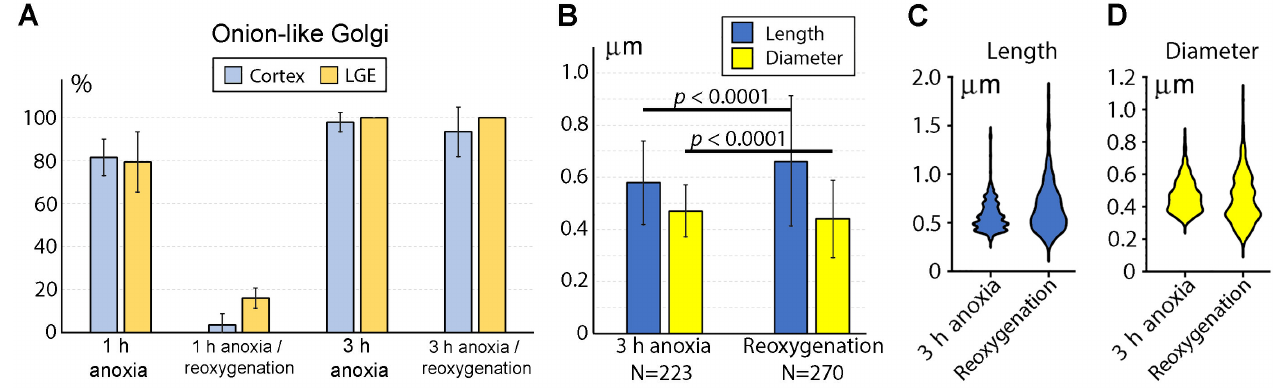
Figure 4. ( A ) Reoxygenation of the anoxia-exposed mouse embryo brains down-regulates percentage of the onion-like GA after 1 h, but not after 3 h anoxia. Percentages of swirled GA are expressed as mean ± SD for each spatiotemporal location (Table 1). ( B – D ) Morphometric comparison of mitochondria in the mouse embryo cerebral SVZ after 3 h anoxia versus 3 h anoxia/reoxygenation. ( B ) Length and diameter of mitochondria are expressed as mean ± SD. Ns are numbers of analyzed 3D-reconstructed mitochondria. ( C , D ) Estimation plots for length and diameter of the mitochondria.